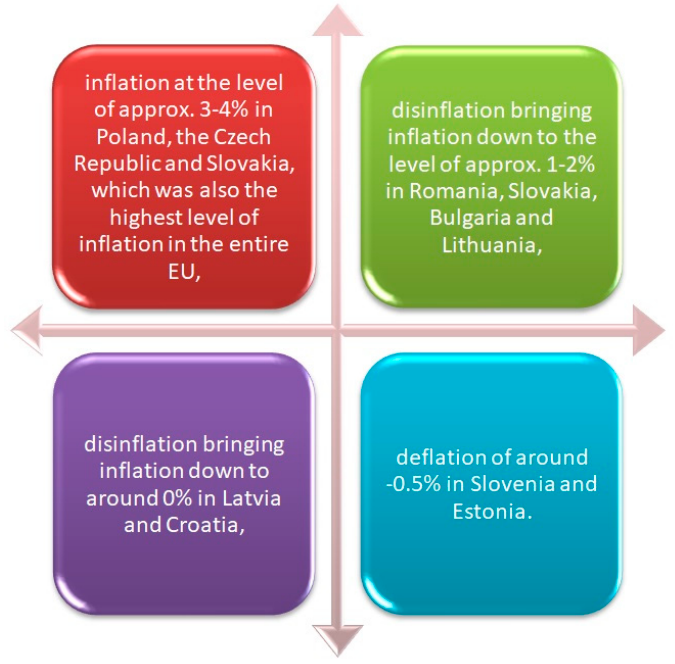
Figure 5. Phenomena as a result of the evolution of supply and demand [22,23]. The authors emphasize that the COVID-19 pandemic was a serious shock to the economies of Central Europe. The analysis of the real GDP growth rate, unemployment rate and inflation resulted in a change in the economic situation of these countries in 2020. Economies in Europe decreased by almost 5% in comparison with 2019 to 2020. Unemployment has risen. Inflation was 2.5% and 1% lower in 2019 and 2020, respectively, as shown in Figure